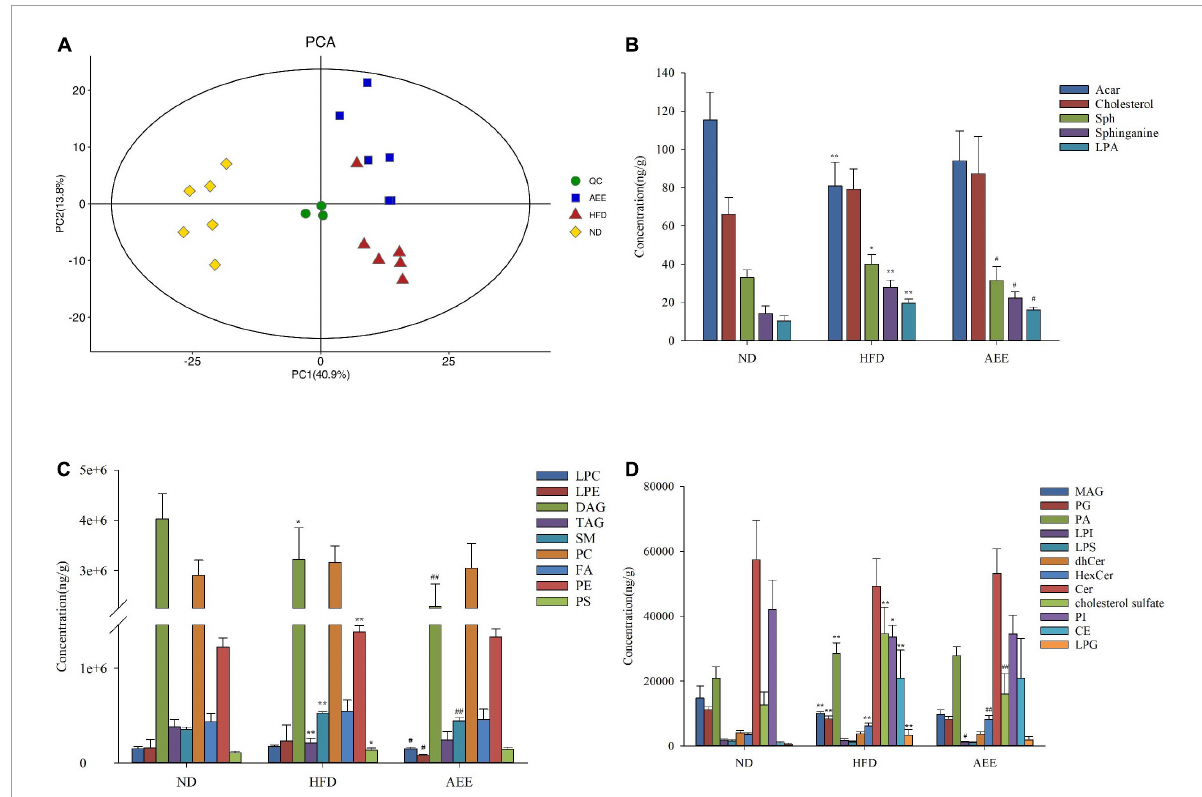
FIGURE2 Lipidomics analysis of mice liver samples. (A) PCA score plots of liver lipid profiling on all samples. (B–D) The concentration of different lipid compositions in the liver. Data are expressed as the means ± SD ( n = 6). Differences were assessed by ANOVA and denoted as follows: ** P < 0.01, * P < 0.05 compared with the ND group; ## P < 0.01, # P < 0.05 compared with the HFD